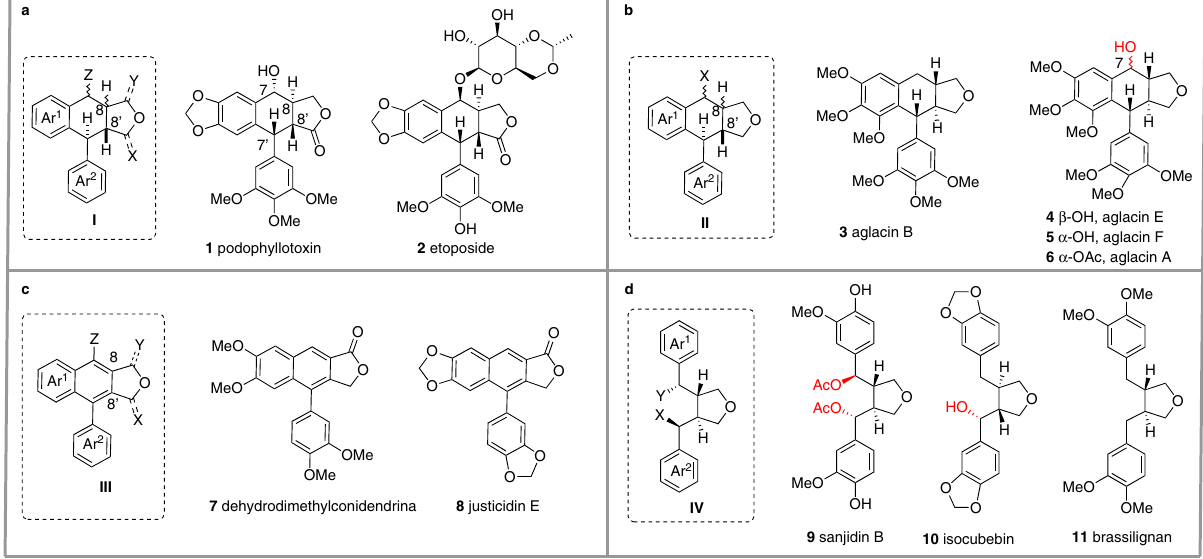
Fig. 1 Representative lignan structures. a Aryltetralin lactones I and its representative natural products: podophyllotoxin ( 1 ) and its derivative etoposide ( 2 ), a market anticancer drug; b Aryltetralin cyclic ethers II and its representative natural products: aglacin B ( 3 ), aglacin E ( 4 ), aglacin F ( 5 ), and aglacin A ( 6) ; c Arylnaphthalene III and its representative natural products: dehydrodimethylconidendrin ( 7 ) and justicidin E ( 8 ); d 3,4-Dibenzyl tetrahydrofurans IV and its representative natural products: sanjidin B ( 9 ), isocubebin ( 10 ), and brassilignan ( 11 ). NATURE COMMUNICATIONS| (2022) 13:3481